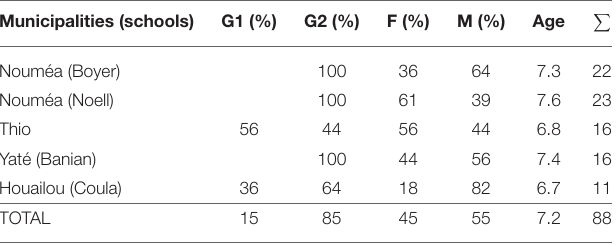
TABLE 1 | Distribution of children in classes by municipality and school according to the school level (G1,1st Grade; G2, 2nd Grade), age and gender (F, female; M, male).